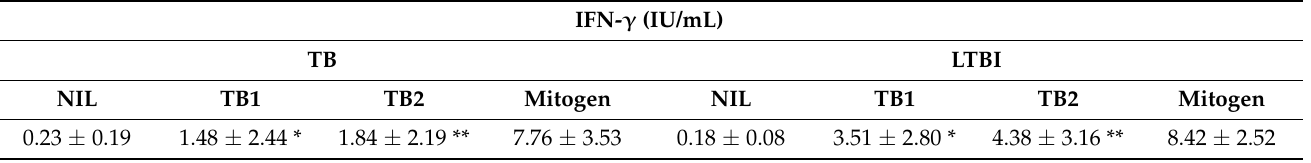
Table 7. The concentration of IFN- γ produced in response to specific M.tb antigens in the IGRA cultures in the groups of TB and LTBI